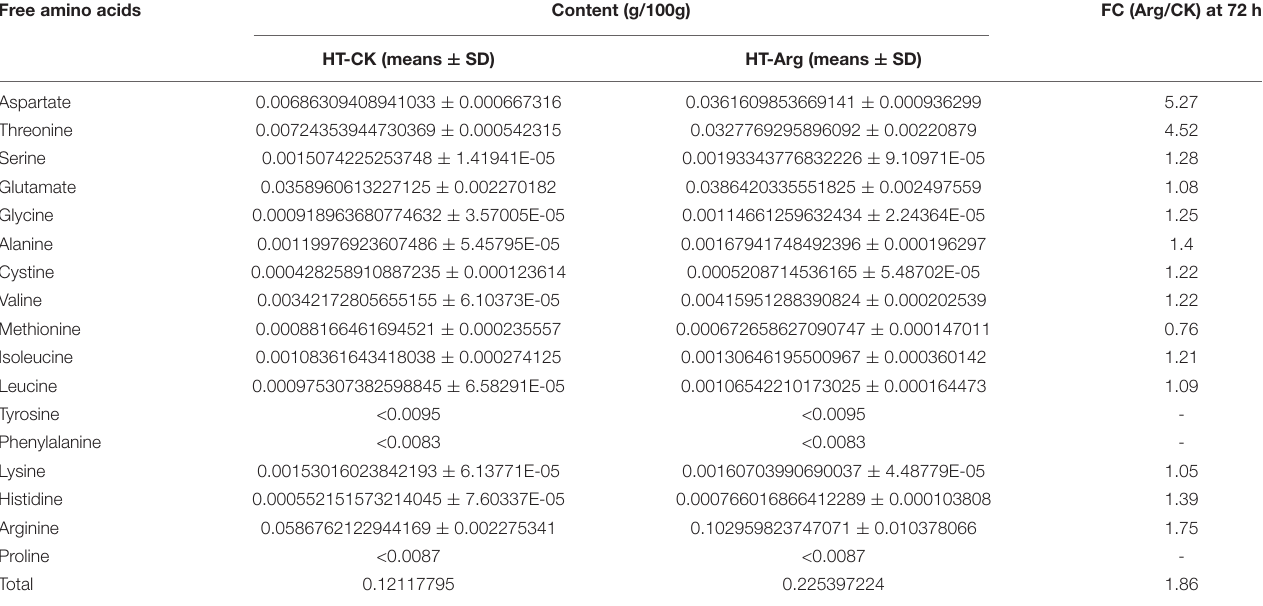
TABLE 3 | The change of free amino acids content in different treatments at 72 h under HT stress. Free amino acids Content (g/100g) FC (Arg/CK) at 72 h HT-CK (means ± SD) HT-Arg (means ±